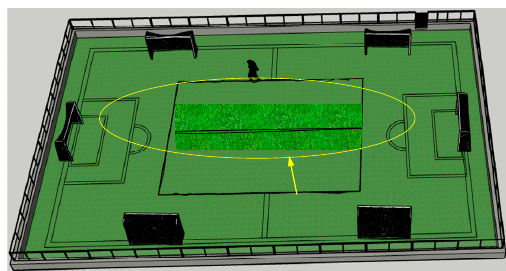
Figure 10. movement trajectory of tester. Figure 10. Movement trajectory of tester. Figure 10. Movement trajectory of tester.